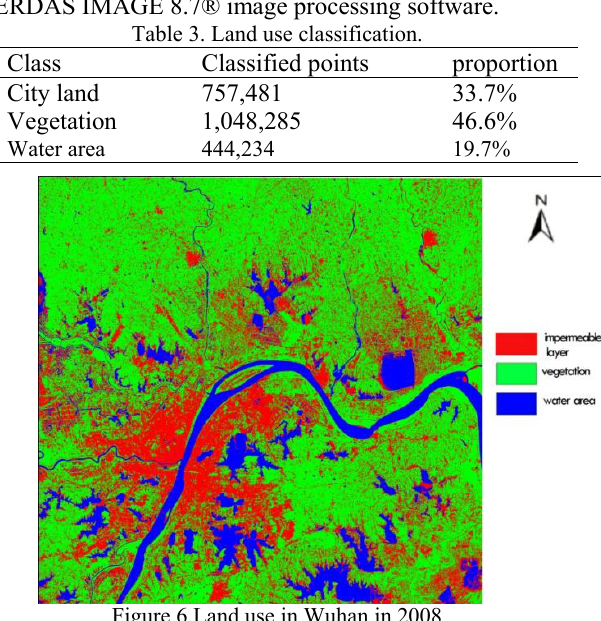
Figure 6.Land use in Wuhan in